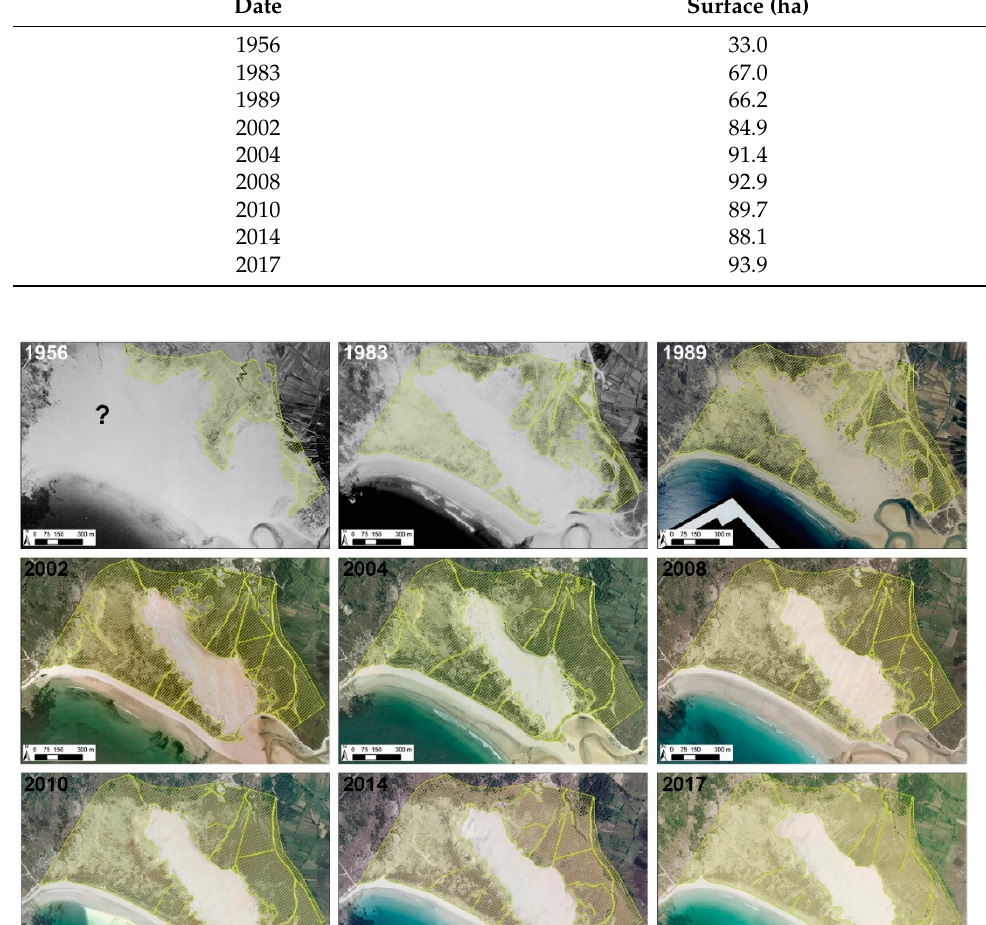
Figure 7. Topographic profiles in dune mobile sector between 2008 and 2015. The position of these profiles appears in Figure 1c in black color. As shown in Figure 7, a decrease in dune elevation occurred during the 2008–2015 period, especially in the crest. While in 2001 the maximum elevation was 21 m, this eleva- tion decreased to 20.31 m in 2008, 19.59 m in 2010 and 18.51 in 2015. These modifications